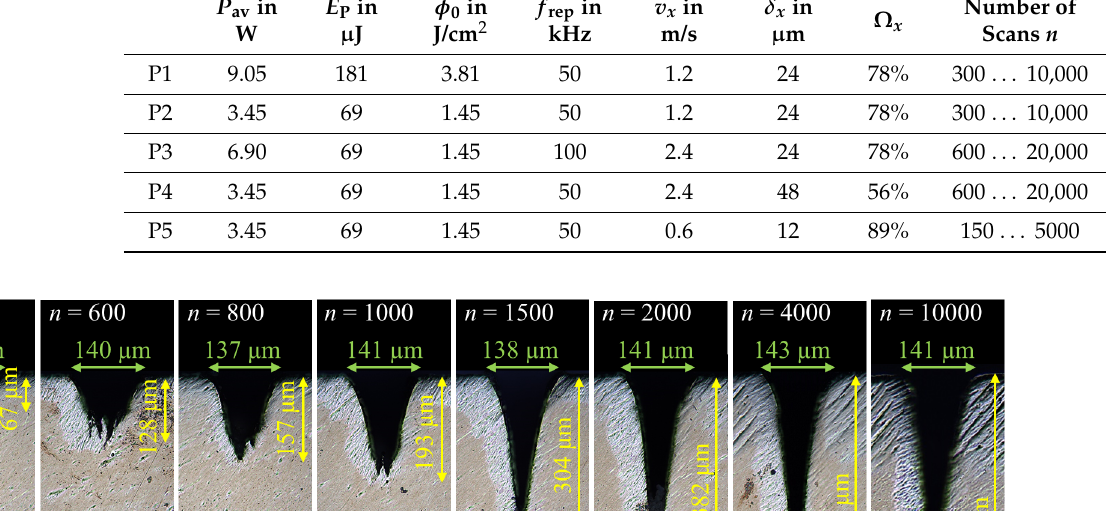
Table 1. Sets of parameters as used for micromachining of grooves with different depths and widths.